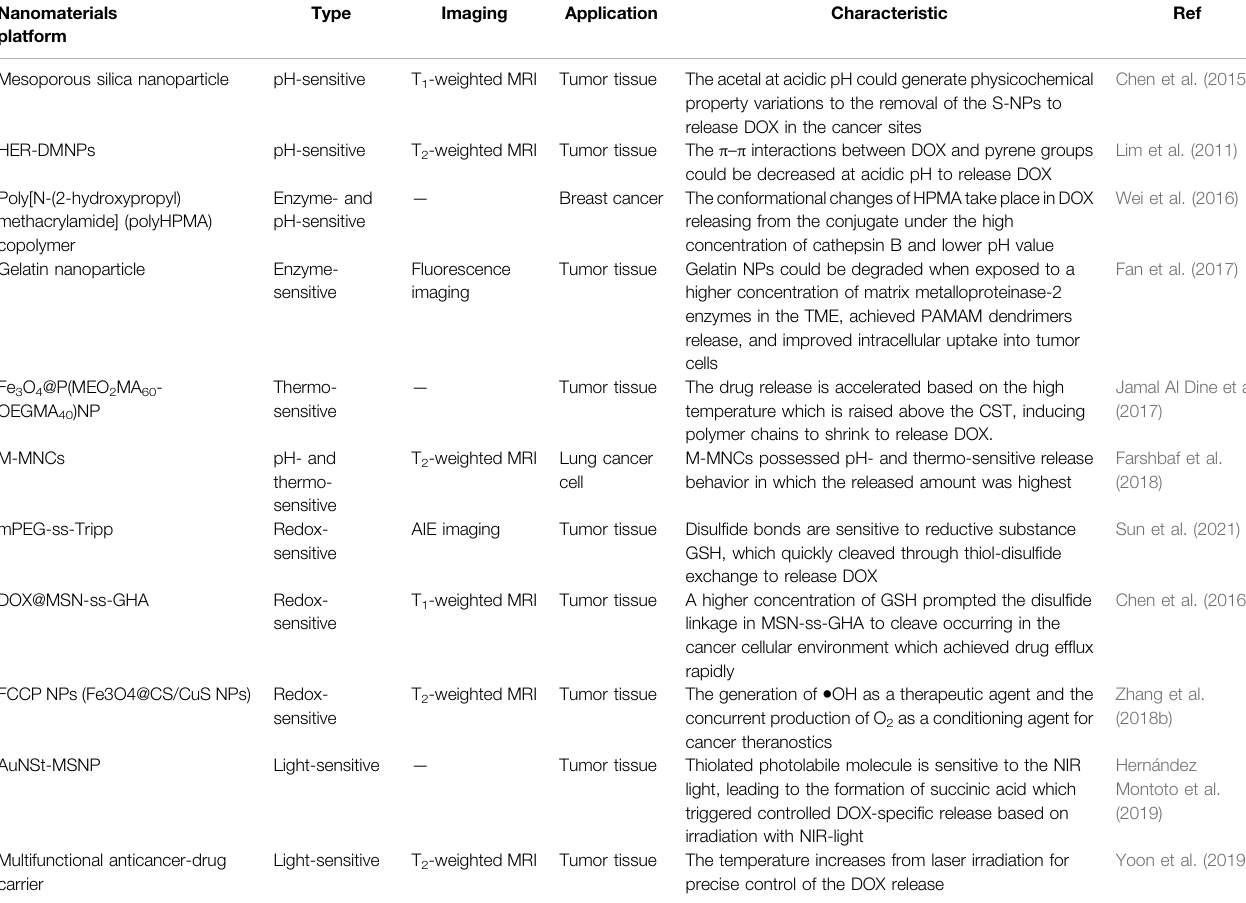
TABLE 1 | Illustrative examples of NDDIP and their biomedical applications. Nanomaterials